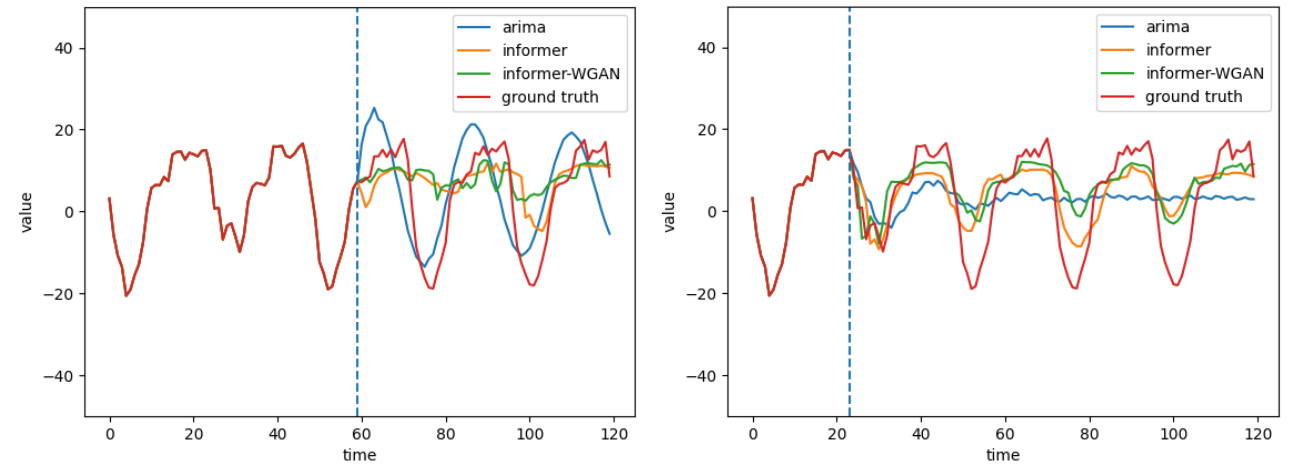
Figure 8. Imputation results of different methods on ETTh1 dataset at missing rates of 50% and 80%.